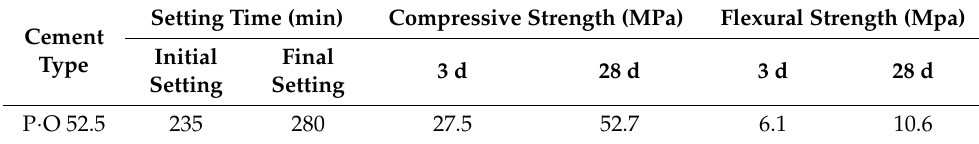
Table 1. Main performance parameters of cement.